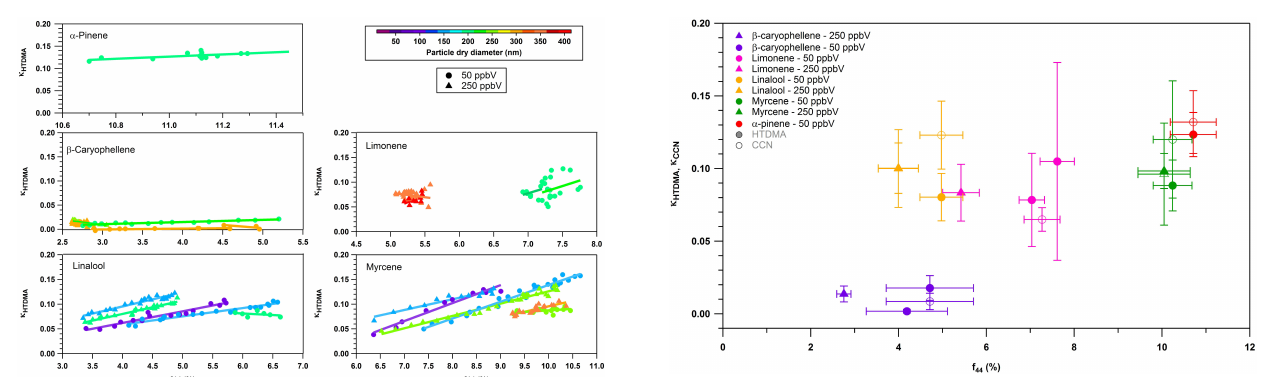
Fig. 9. The relationship between hygroscopicity of particles of a single size (represented by κ HTDMA ) and f 44 measured simulta- neously by the ToF-AMS for each precursor at both high and low initial mixing ratios. The linear fit parameters and coefficient of de- termination ( r 2 ) for each selected particle size are listed in Table 5.